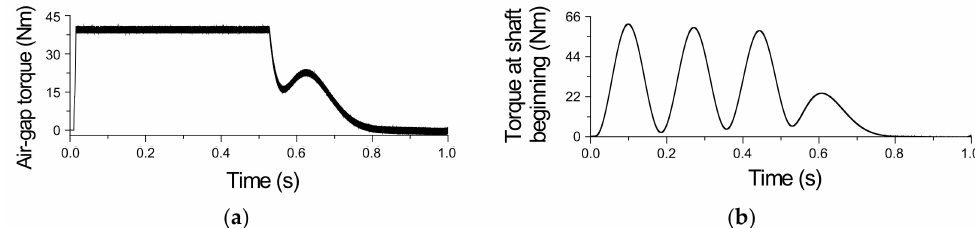
Figure 8. Waveforms of the air-gap torque of an induction motor ( a ) and the torque at the point of connection of the induction motor with the transmission shaft ( b ) when starting the motor in the drive system shown in 0.